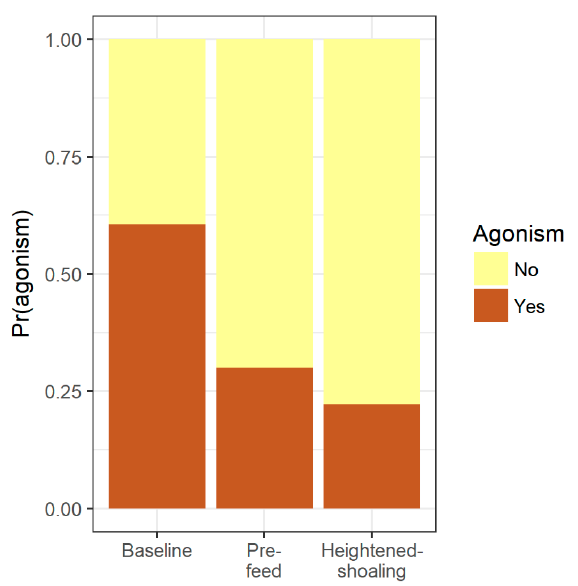
Figure 5. Probability of observing agonism during a ten-second window during each period type . Compared to baseline periods, zebrafish were significantly less agonistic during pre-feed and heightened-shoaling periods (both p ’s < 0.0001; 45 video clips, 450 ten-second windows, n = 6 tanks, 10 zebrafish per tank).